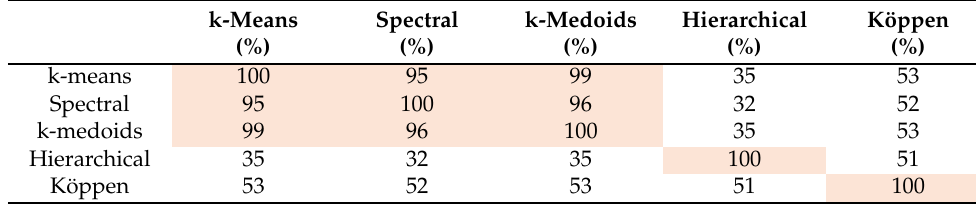
Table 3. Rand Index (RI) for 5 clusters.